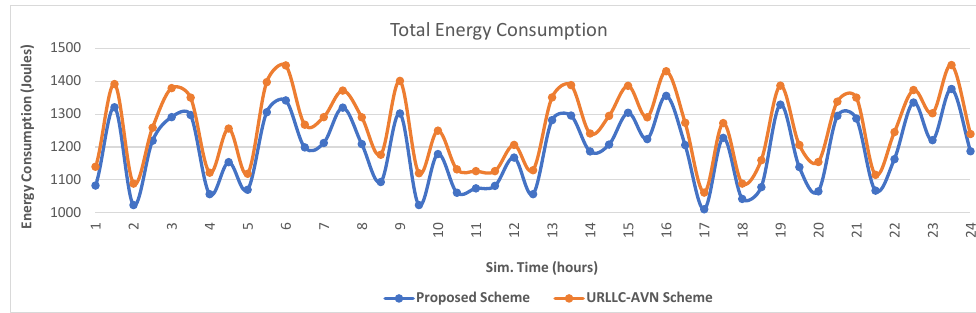
Figure 11. The total energy consumption observed for each